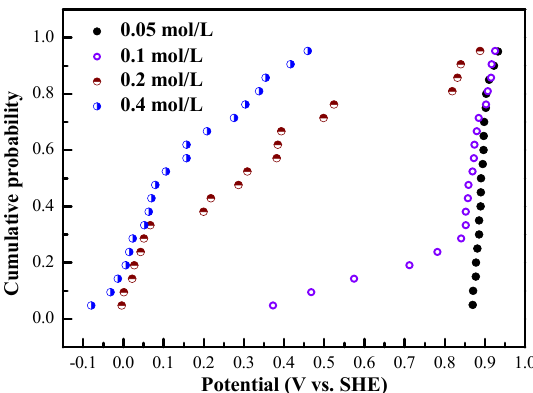
Potential (V vs. SHE) Potential (V vs. SHE) Figure 4. Cumulative probability distribution of pitting potential of reinforcing bars under different Figure 4. Cumulative probability distribution of pitting potential of reinforcing bars under di ff erent chloride concentration at pH 12.5. chloride concentration at pH 12.5. Figure 4. Cumulative probability distribution of pitting potential of reinforcing bars under different chloride concentration at pH 12.5.